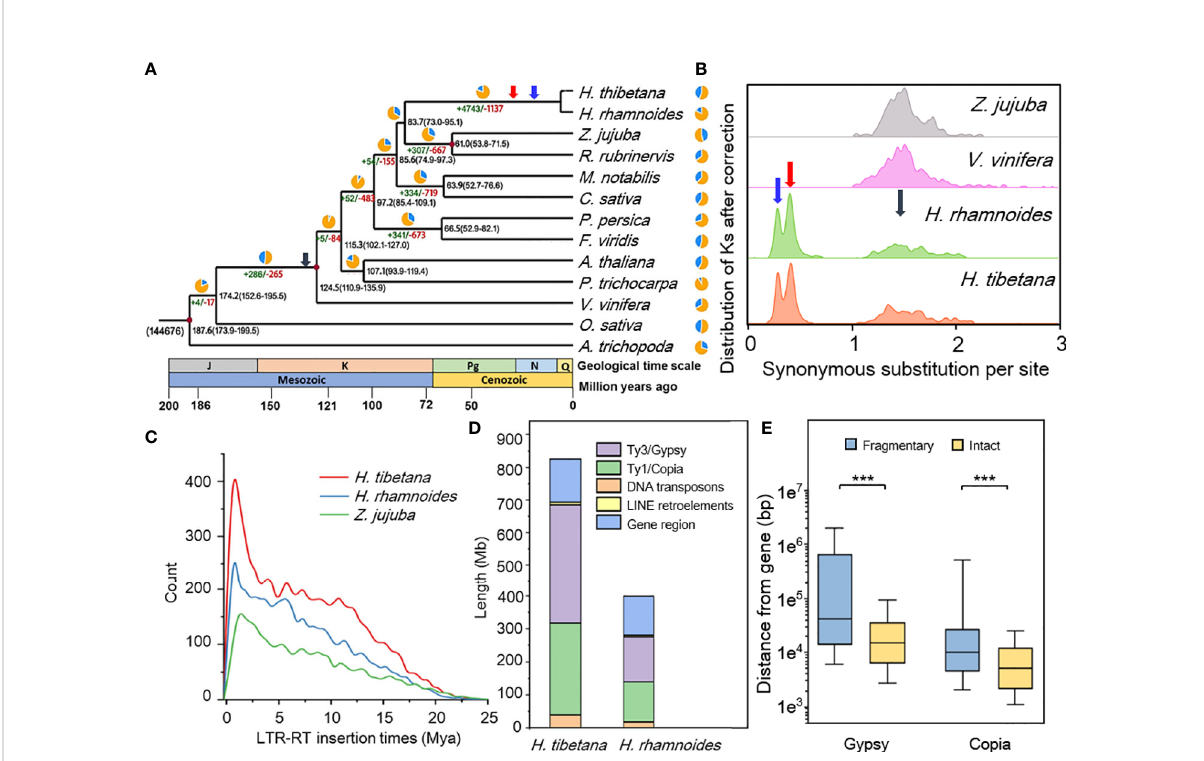
FIGURE 2 (A) Phylogenetic tree constructed of ” H. tibetana and 12 other representative species. Divergence time estimation and gene family changes among 13 plant species. A. trichopoda was used as a basal species in the phylogenetic tree. The black number at each node denotes estimated divergence time from present (million years ago). The number at the root (144,676) denotes the total number of gene families, and the green/red numbers around each branch denote gene family gain/loss number. The red dot as the corrected time of the Timetree website; (B) Synonymous nucleotide substitutions ( Ks ) distribution in syntenic blocks after correction. Syntenic blocks (involving ≥ 10 colinear genes) within a species or between two species were collected, and the median Ks values for each block were obtained. Distribution of Ks between paralogs or orthologs of ” H. tibetana - ” H. tibetana showed HRT (blue arrow) and HAT (red arrow) represent the two tetraploidization events, ECH (grey arrow) represents the core-eudicot common hexaploidization (WGT, g event); (C) Distribution of LTR retrotransposon insertion time of ” H. tibetana, H. rhamnoides and Z. jujuba ; (D) The proportions of TEs in ” H. tibetana genome; (E) Distance between intact/fragmentary LTR ( Gypsy / Copia ) and gene, *** signi fi cant at < 0.001